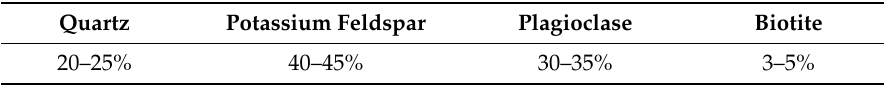
Figure 1. Observations of the granite at different scales: ( a ) naked eye observation and ( b ) a thin section micrograph showing the main mineralogical composition of the rock. Table 1. Main mineral contents of granite.